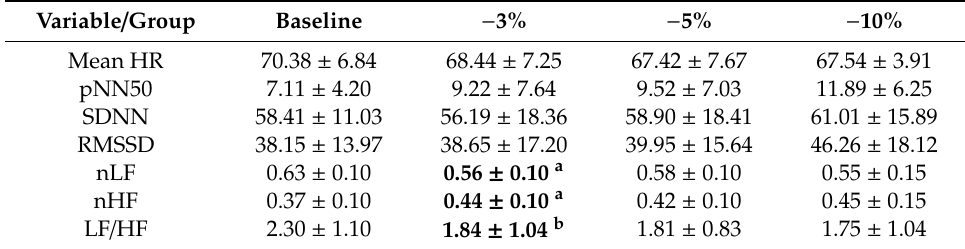
Figure 5. HRV parameters under each experimental condition: ( a ) time and ( b ) frequency-domain HRV results. * p < 0.03 and ** p < 0.01 between the baseline and stimulation conditions (Wilcoxon rank-sum test). HRV—heart rate variability. Table 1. Results of heart rate variability analysis (Mean ± Standard